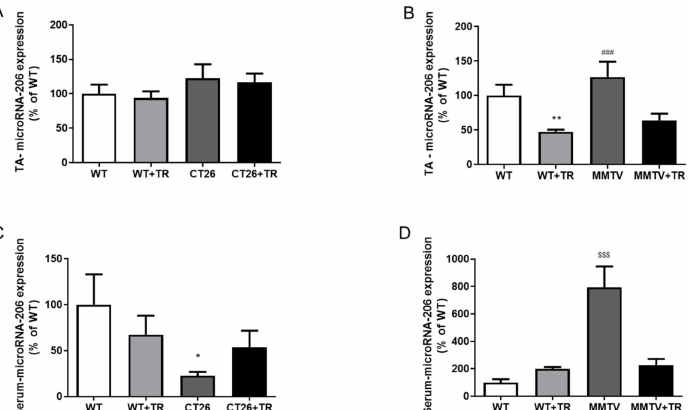
Figure 6. MicroRNA-206 expression in tibialis anterior (TA) skeletal muscle and circulating in CT26- cachectic and MMTV-PyMT-non-cachectic mice. ( A ) CT26 model, skeletal muscle microRNA-206 expression. ( B ) MMTV model, skeletal muscle microRNA-206 expression. ( C ) CT26 model, serum